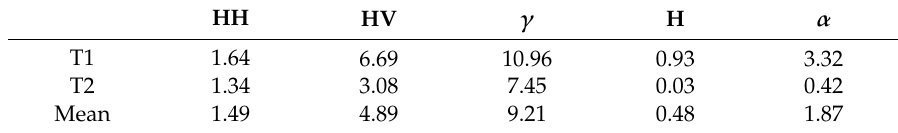
Table 6. SCRs (unit: dB) of the two detected ship targets in di ff erent polarimetric parameter images. HH HV γ